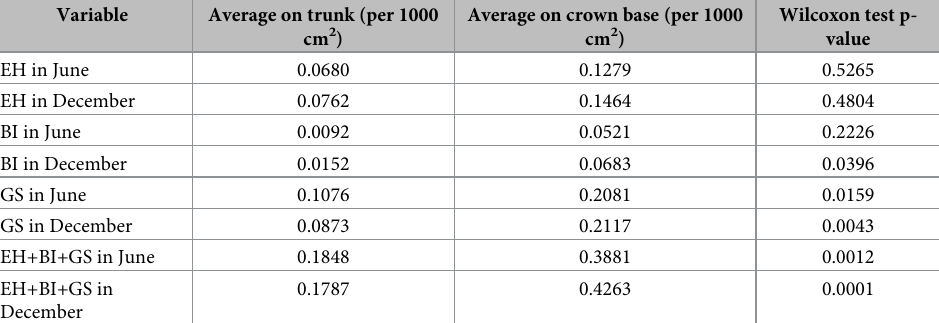
Fig 14. Distribution of emergence holes, bark injuries and gallery slits combined (EH+BI+GS) on orientation and height. Table 3. Wilcoxon test for the distribution of infestation damages on trunk and crown base (per 1000 cm 2 ).